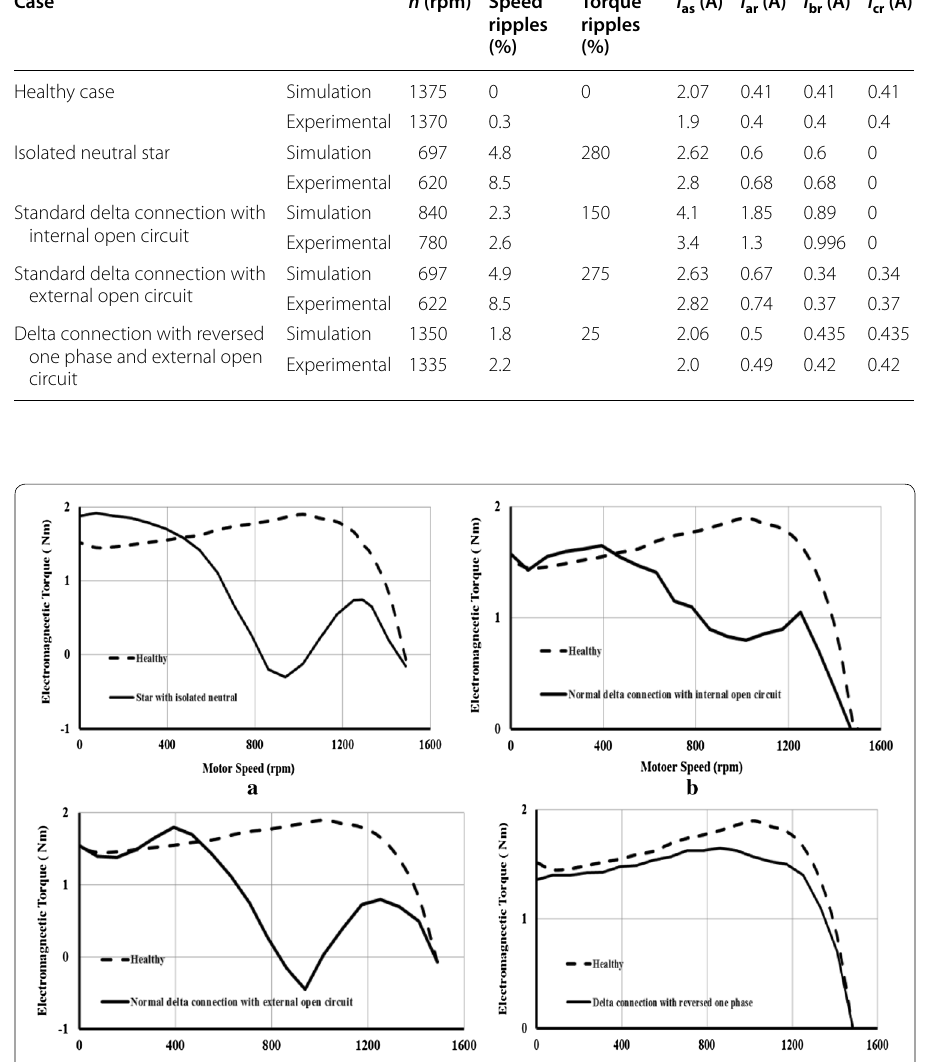
Table 1 Summarized simulation and experimental results Case